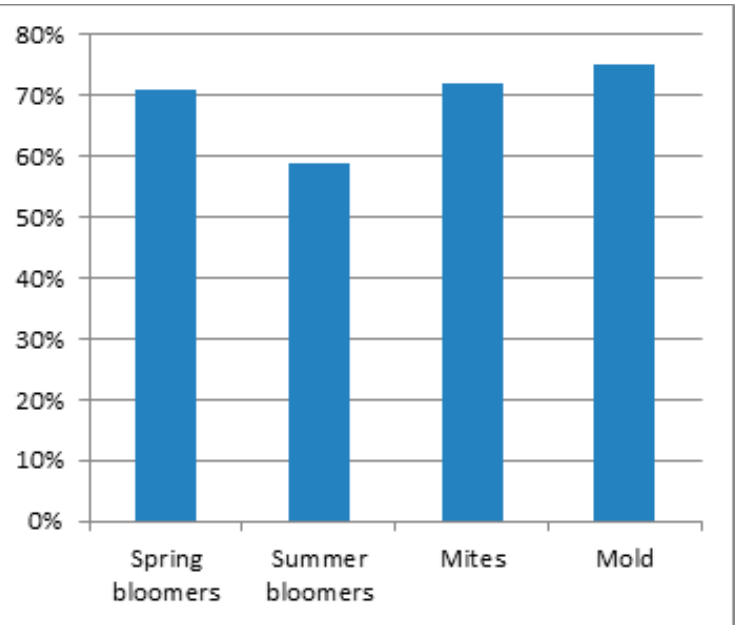
Figure 3. Kappa coefficients when comparing SPT and specific serum IgE.